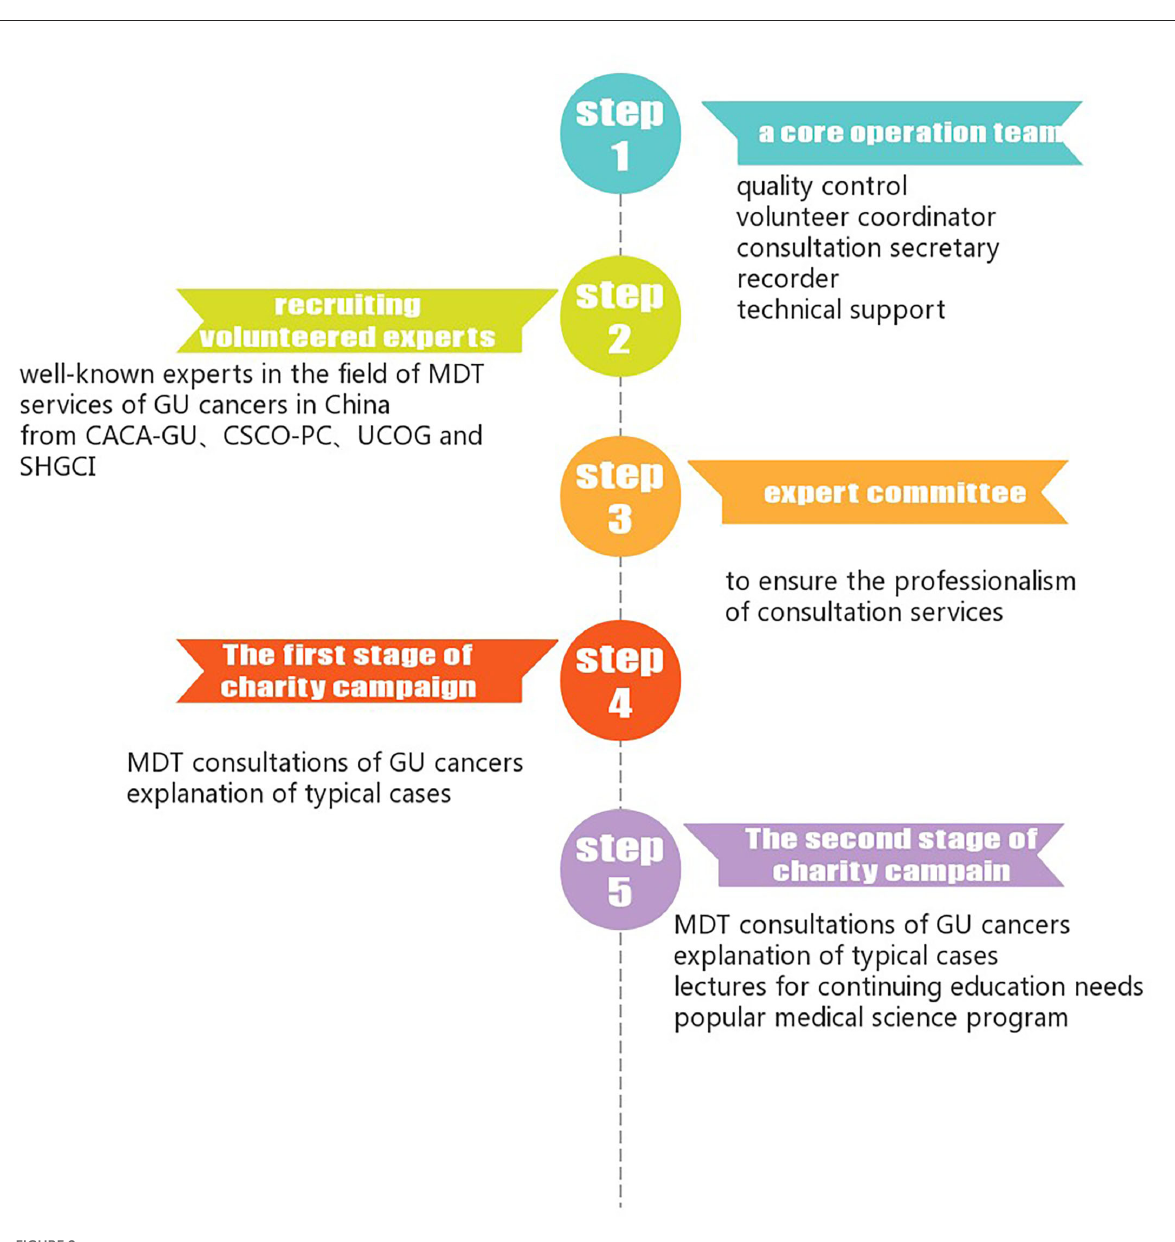
FIGURE2 Work flow of China genitourinary (GU) MDT charity